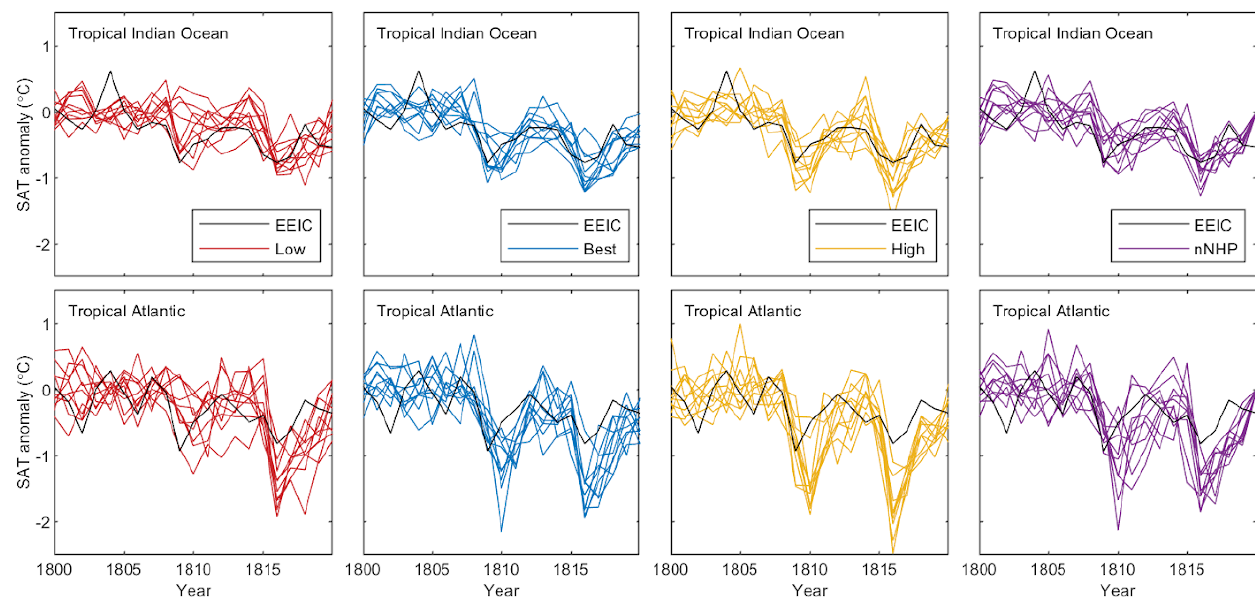
Figure 8. Annual mean surface air temperature anomalies from shipborne measurements of the English East India Company (EEIC) (Brohan et al., 2012) over the tropical Indian and Atlantic oceans (black line) compared to similarly sampled model simulations from the Low, Best, High, and nNHP forcing ensembles as labeled. Anomalies are taken with respect to the years 1800 to